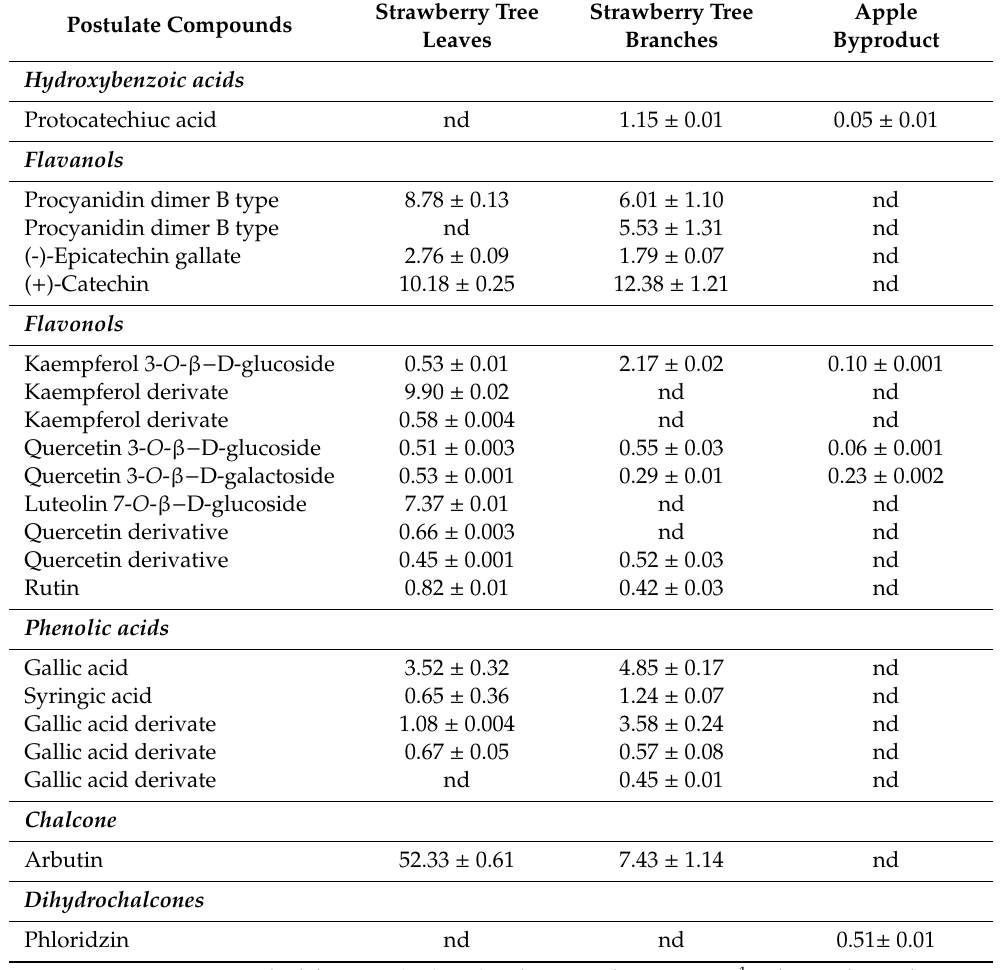
Table 4. Concentration of phenolic compound present in